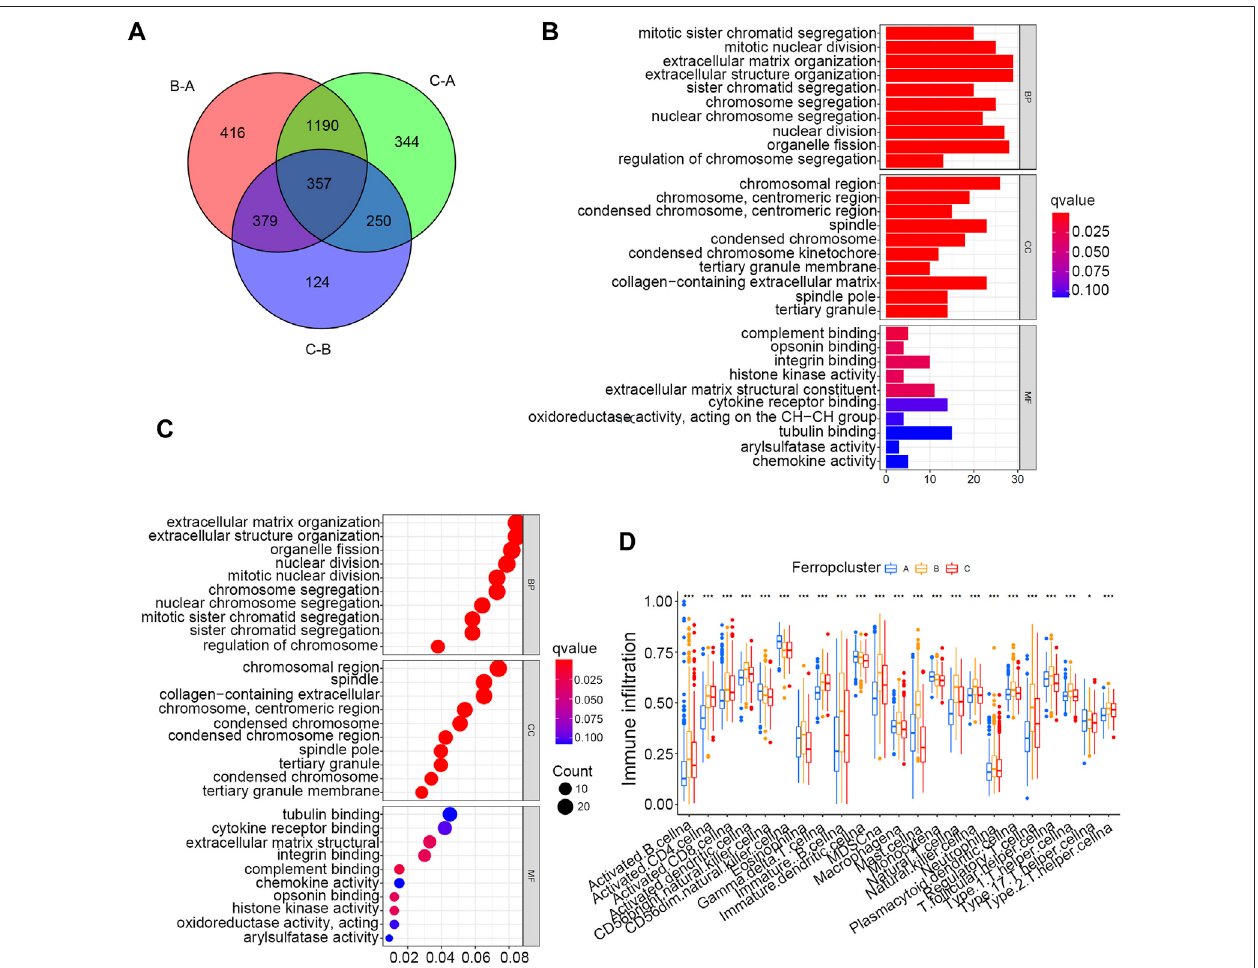
FIGURE 3 | GO and ssGSEA analyses based on DEGs in distinct Ferropclusters. (A) 357 DEGs between three distinct Ferropclusters. (B) Bar plot presenting GO enrichment analysis. (C) Bubble chart presenting GO enrichment analysis. (D) ssGSEA analysis of three distinct Ferropclusters. The asterisk symbol indicated the statistical p -value. (* p < 0.05; ** p < 0.01; *** p < 0.001).